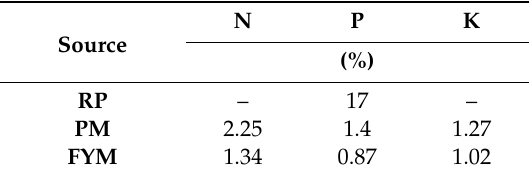
Table 1. NPK contents of rock phosphate (RP), poultry manure (PM) and farmyard manure (FYM) used in the phosphate-solubilizing bacteria